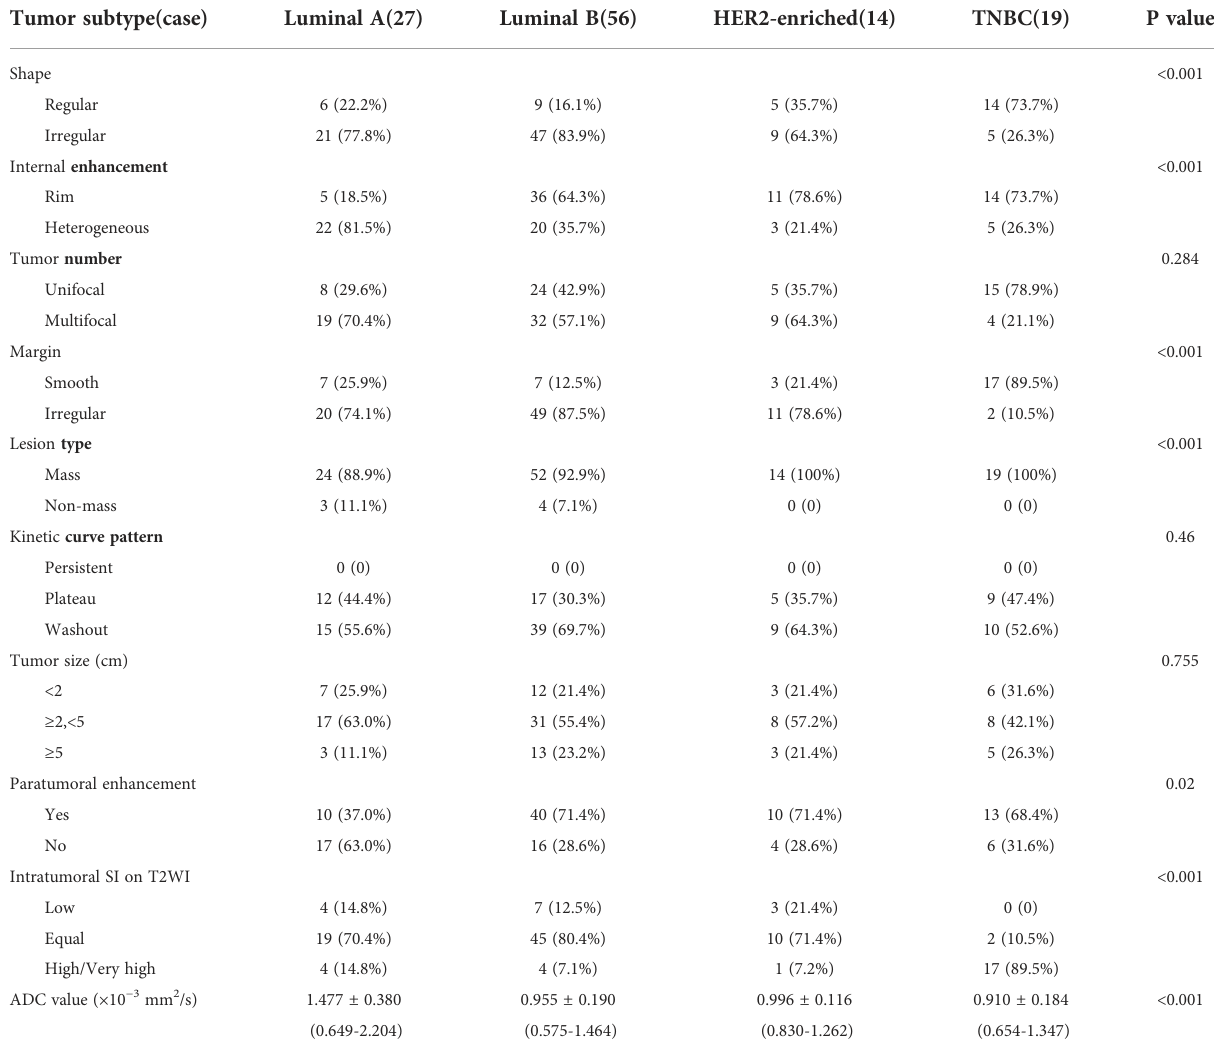
TABLE 2 MR imaging features strati fi ed by molecular subtypes. Tumor